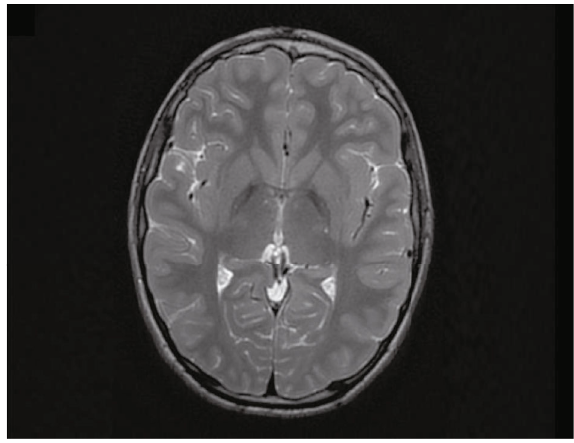
Figure 2: Axial T2WI: symmetric areas of low signal T2 of the globus pallidus with relatively central hyperintensity giving the appearance of eyes of a tiger.